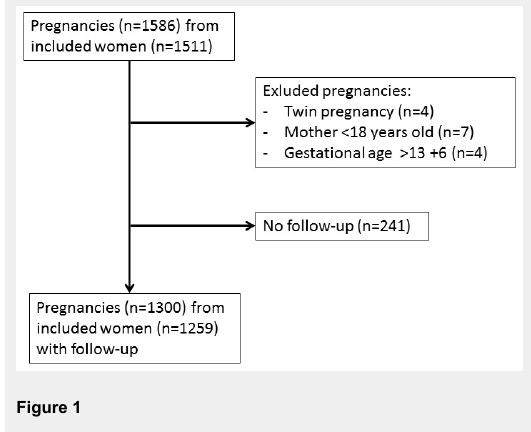
Flow chart of the study. The participating women were subsequently recruited by nine obstetricians based in private